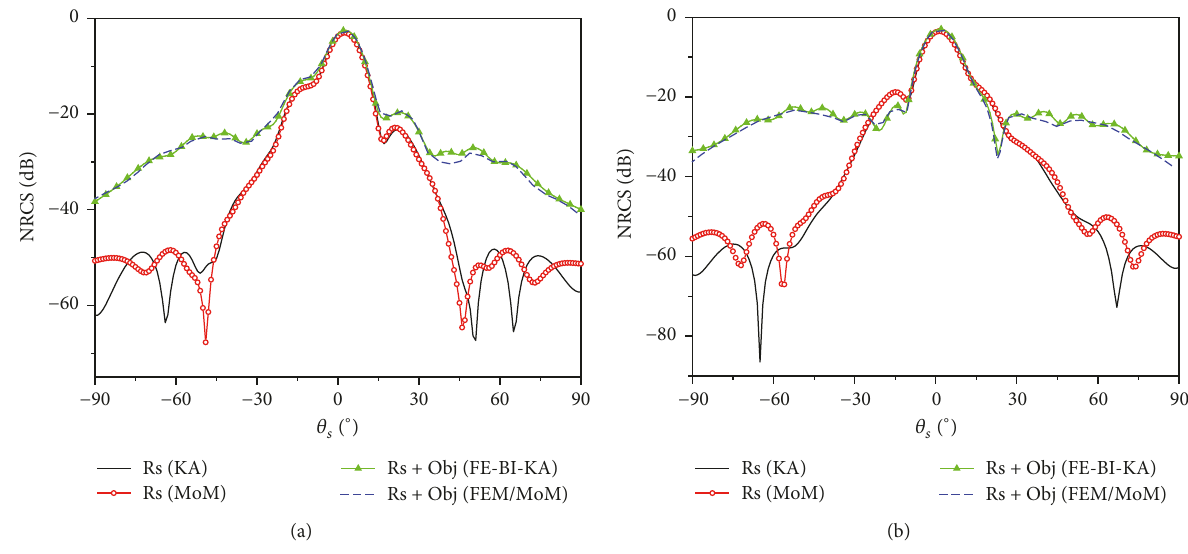
Figure 3: Bistatic NRCS of a 3D PEC sphere buried under dielectric rough surface: (a) 𝑋 - 𝑍 Plane and (b) 𝑌 - 𝑍 Plane.